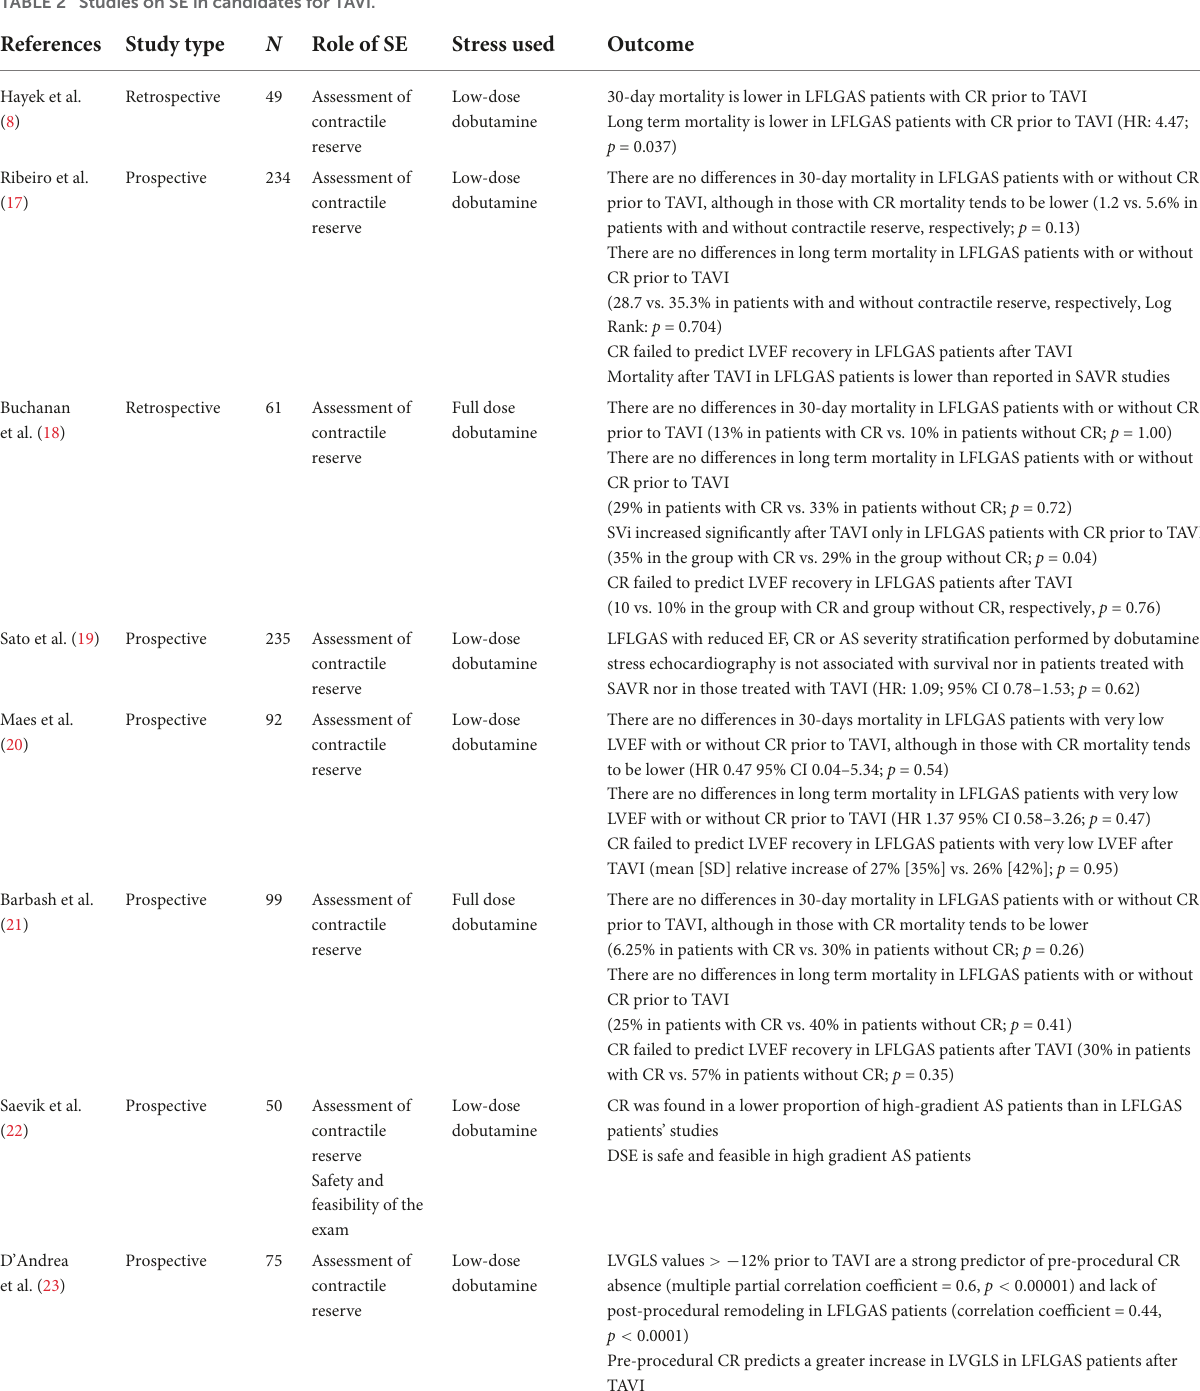
TABLE 2 Studies on SE in candidates for